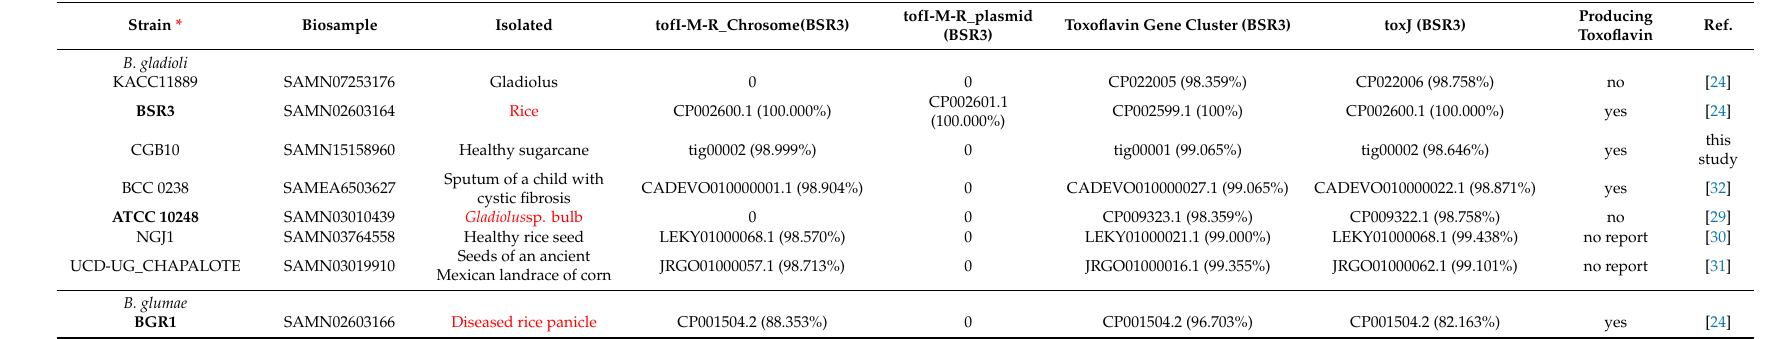
Table 1. Selected B. gladioli and B. glumae strains for genome comparison